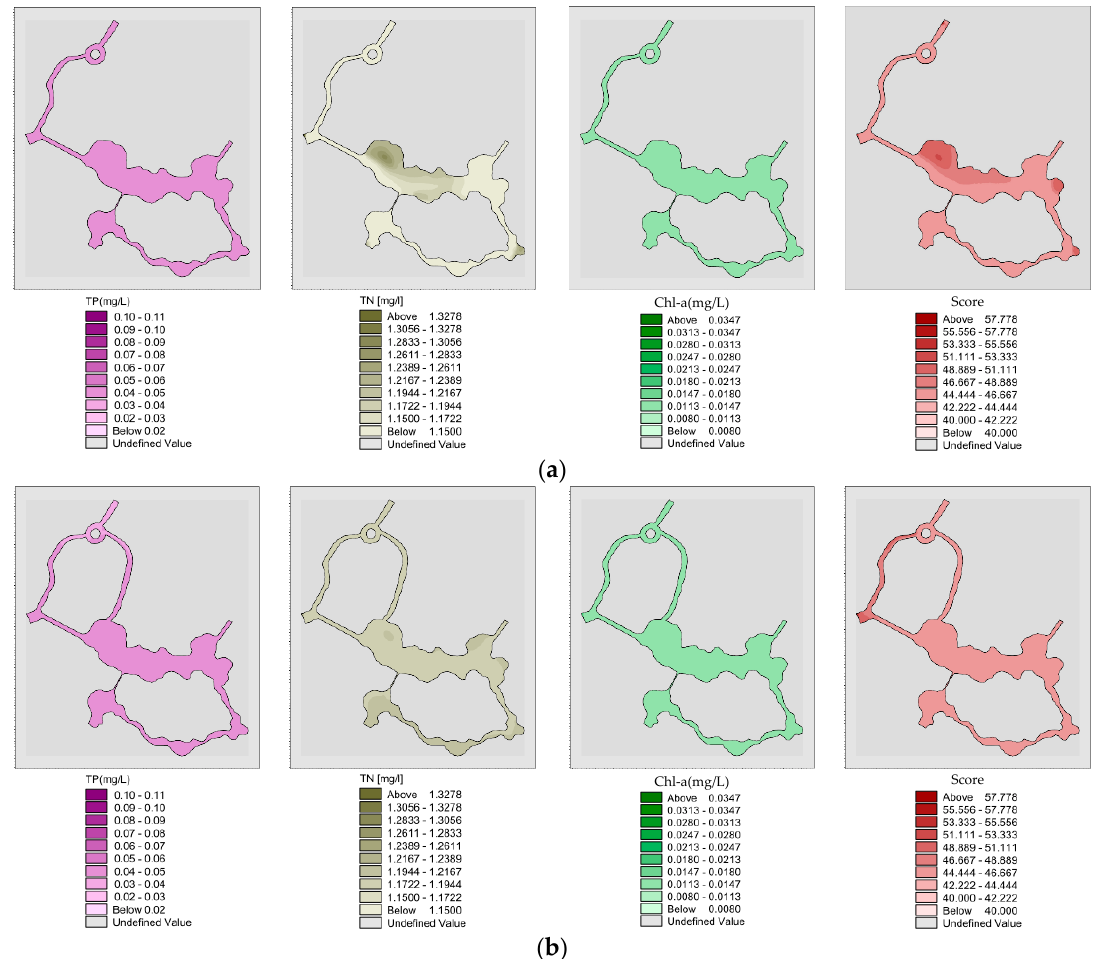
Figure 17. ( a ) Spatial distribution of “unilateral” river TP, TN, Chl-a and eutrophication scores by sluice diversion in summer; ( b ) Spatial distribution of “bilateral” river TP, TN, Chl-a and eutrophication scores by sluice diversion in summer.